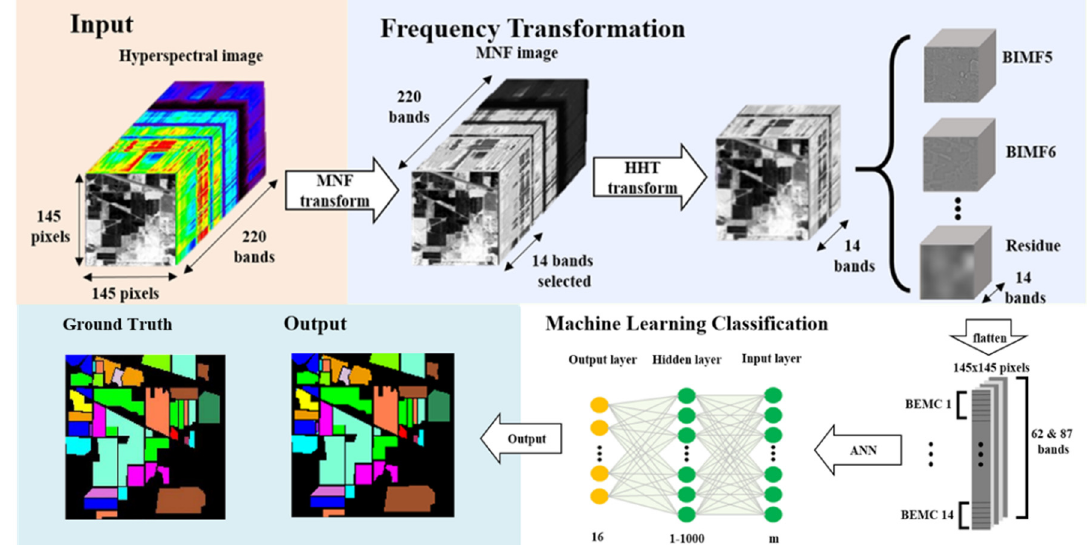
Figure 1. The flow chart of the proposed classification process illustrated with the IP dataset.